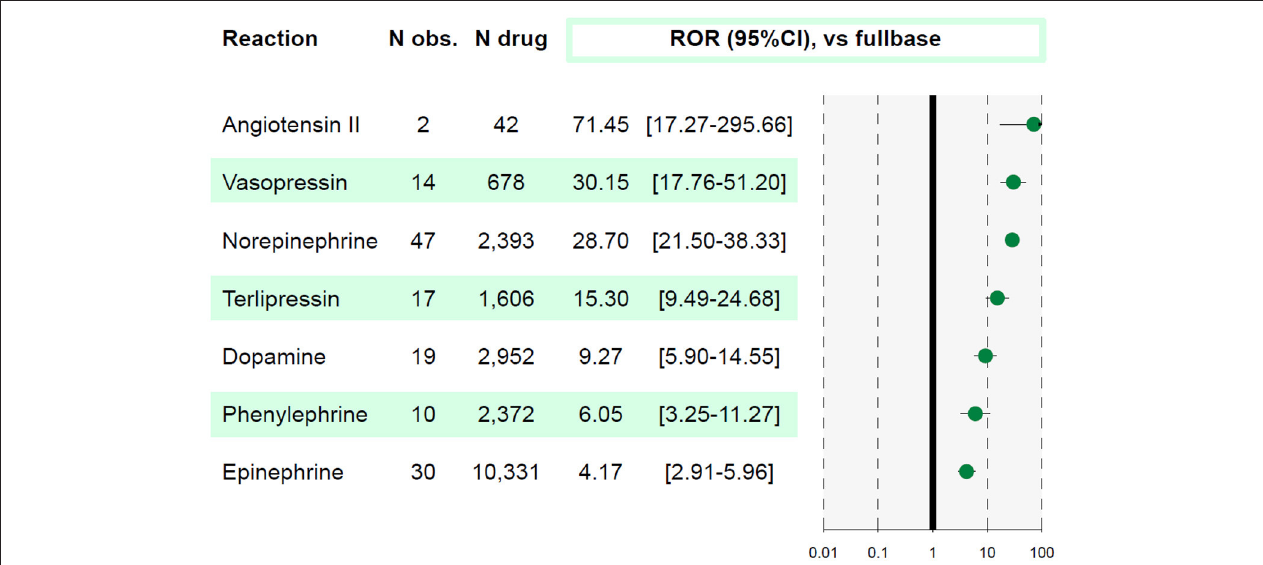
FIGURE 1 | Association between acute mesenteric ischemia and each molecule. A reporting odds ratio (ROR) value is considered significant when lower bound of 95% confidence interval (95%CI) is above 1. The studied reaction is acute mesenteric ischemia (AMI). N obs ., number of observed AMI reports; N drug , number of reports involving the studied drug in